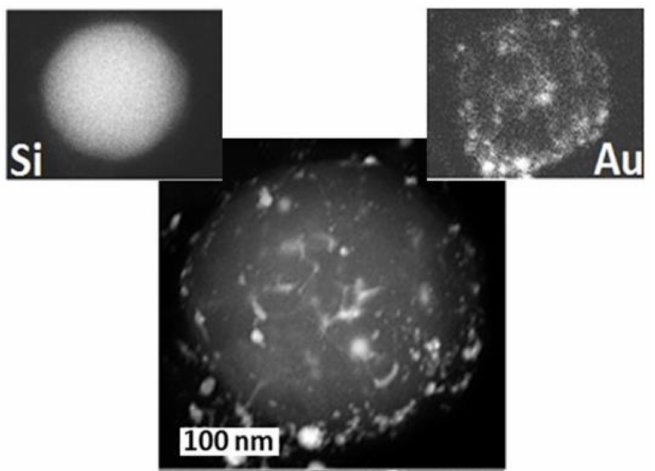
Figure 13. TEM image of Au-Si alloyed NP (Au content ≈ 5 at. %, see the upper right inset) produced by ns-laser ablation of a thin Au film on a bulk Si substrate in water at the laser intensity ~1 GW/cm 2 , with its Si and Au elemental maps. The scale bar is shown in the bottom image by the frame with the scale